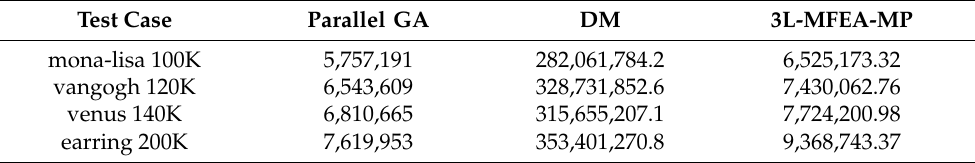
Table 4. Comparison of the three